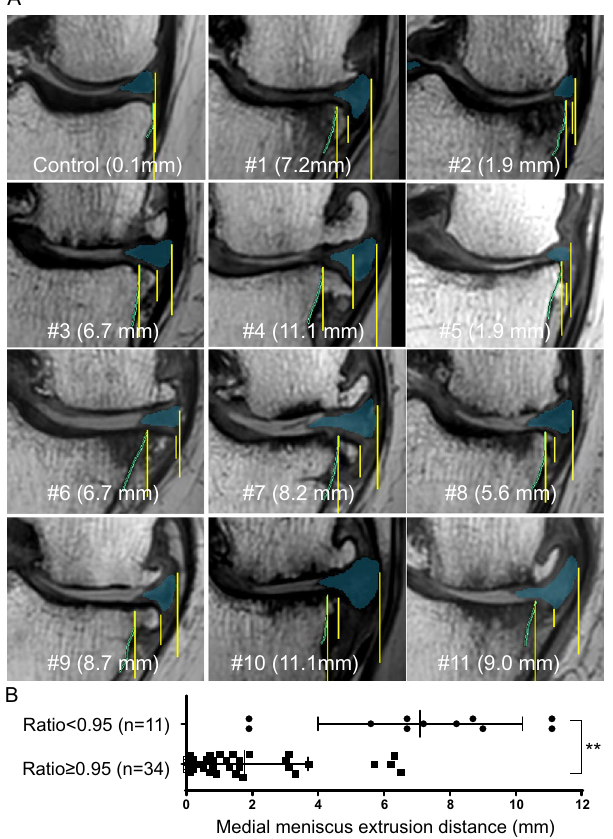
Figure 4. Medial meniscus (MM) extrusion determined by 2D MRI. ( A ) Medial meniscus in coronal images of proton-weighted MRI. The images are ordered from highest to lowest cartilage area ratios at the medial tibia; the MM extrusion distance is also shown. The three yellow lines indicate, from the center, the vertical line of the outer margin of the tibia, the vertical line of the outer margin of the spur, and the vertical line of the outer margin of the MM. ( B ) Comparison of the MM extrusion distance in the two groups separated by cartilage area ratios at the medial tibia of 0.95. Average with SD is shown. **; p < 0.01 by the Welch two-sample